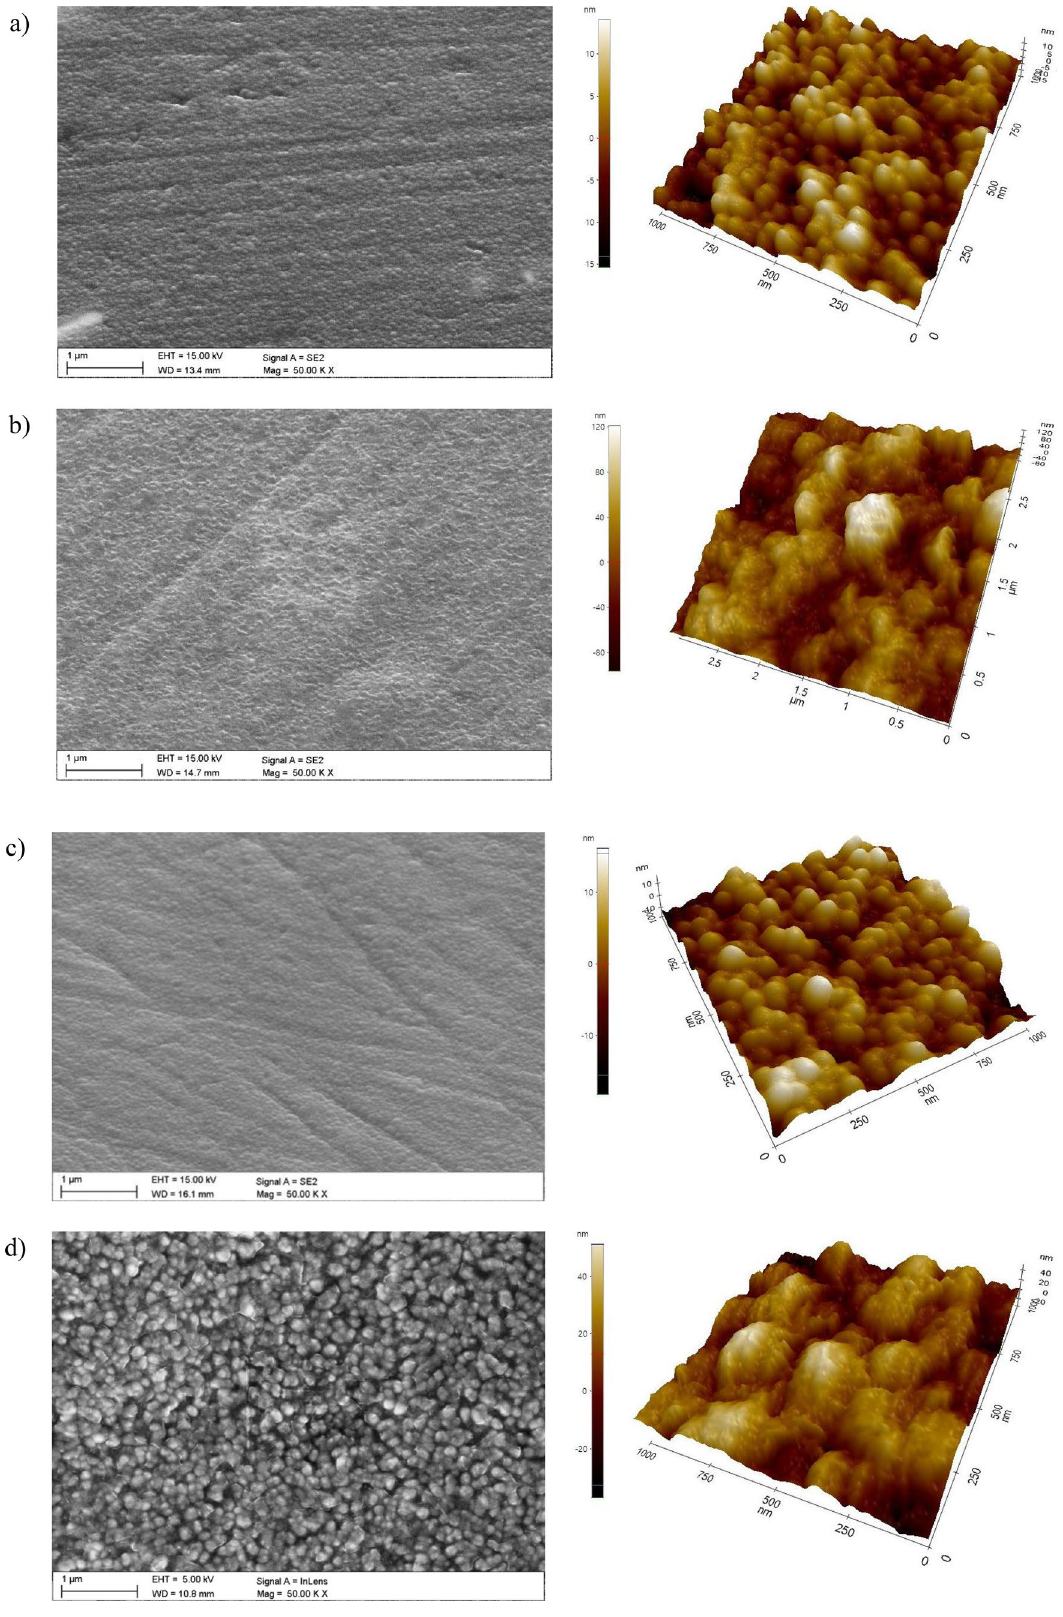
Figure 1. Morphology of PVD/ALD coatings (SEM, AFM): ( a ) Ti/Al 2 O 3 + TiO 2 on AE42, ( b ) Ti/Al 2 O 3 + TiO 2 on LAE442, ( c ) Ti + TiO 2 /Al 2 O 3 + TiO 2 on AE42, ( d ) Ti + TiO 2 /Al 2 O 3 + TiO 2 on